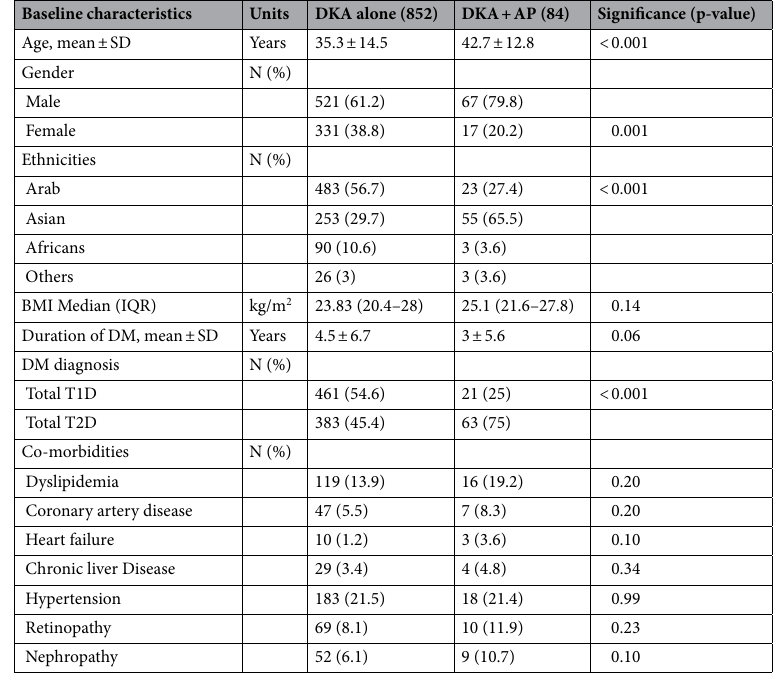
Table 1. Comparison of baseline characteristics between DKA versus DKA with AP patient groups. DKA Diabetic ketoacidosis, AP acute pancreatitis, BMI body mass index, SD standard deviation, IQR interquartile range, DM diabetes mellitus, T1D type 1 diabetes, T2D type 2 diabetes.